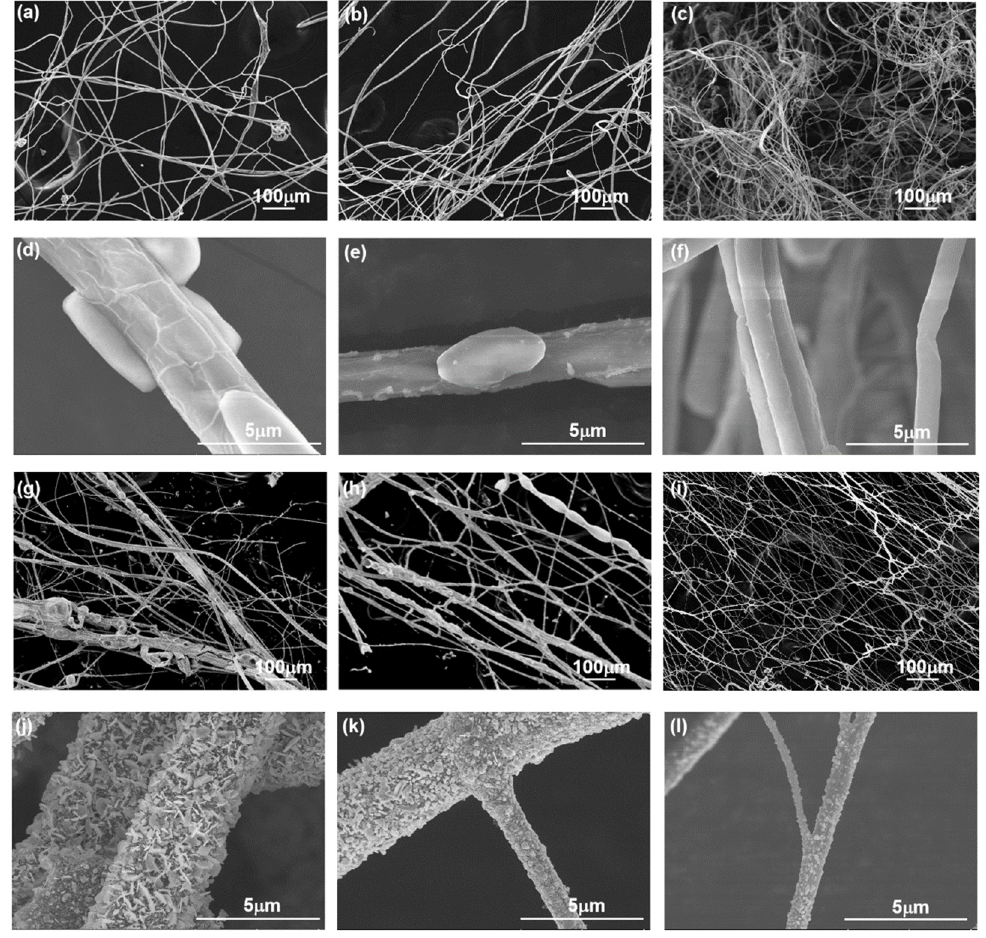
Figure 2. Morphology of the centrifugal-spun silver precursor fibers and annealed silver fibers. SEM images of centrifugal-spun silver precursor fibers with PVP:AgNO 3 weight ratios of 4:15 ( a ), 5:15 ( b ), and 6:15 ( c ). High magnification of SEM images related to centrifugal-spun silver precursor fibers with PVP:AgNO 3 weight ratios of 4:15 ( d ), 5:15 ( e ), and 6:15 ( f ). SEM images of annealed silver fibers with PVP:AgNO 3 weight ratios of 4:15 ( g ), 5:15 ( h ), and 6:15 ( i ). High magnification of SEM images related to annealed silver fiber with PVP:AgNO 3 weight ratios of 4:15 ( j ), 5:15 ( k ), and 6:15 ( l ).